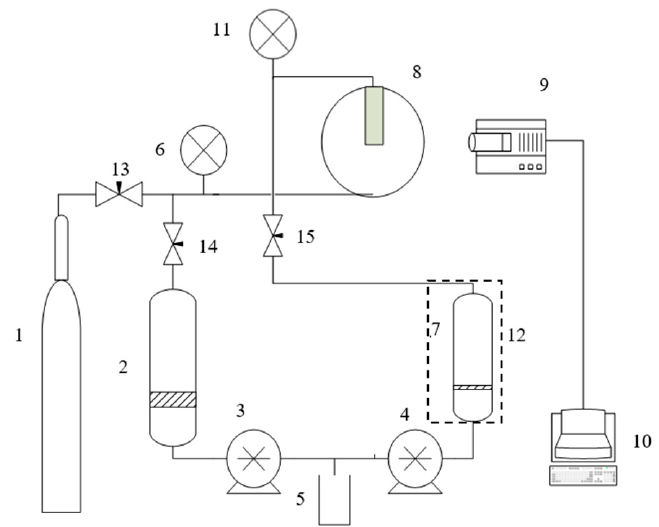
Figure 2. Schematic diagram of the interfacial tension (IFT) experimental apparatus. (1) CO 2 storage bottle, (2) CO 2 intermediate container, (3) constant flow pump, (4) manual pump, (5) water storage tank, (6) and (11) pressure gauge, (7) crude oil intermediate container, (8) high pressure and high temperature interfacial tensiometer, (9) camera, (10) computer, (12) insulated device, (13) and (14) gas needle valve, (15) oil needle